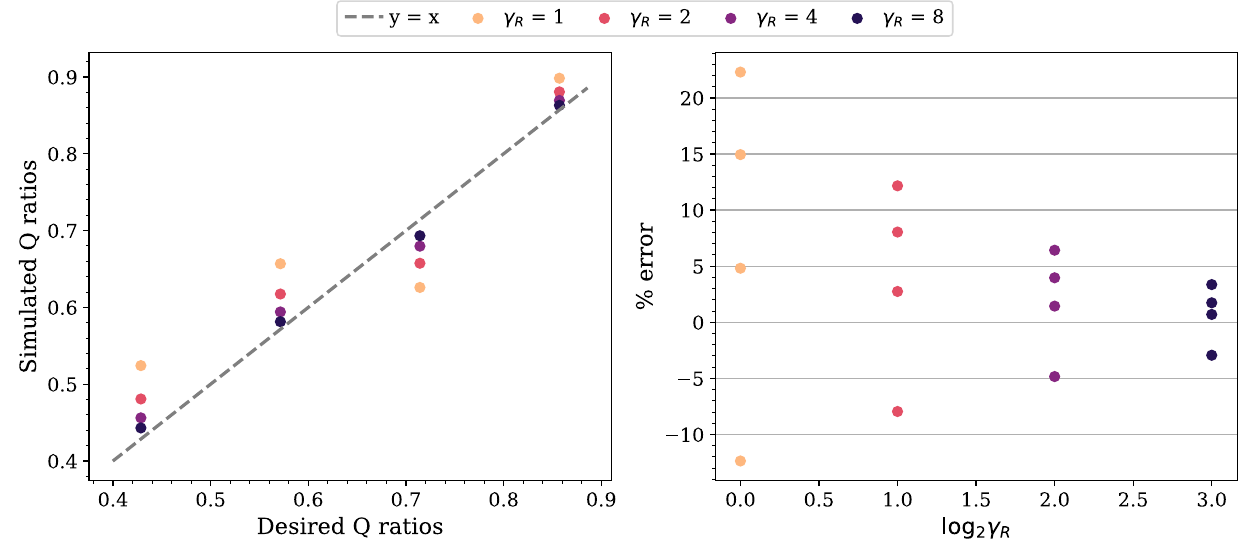
Figure 4. Comparison between the simulated and the desired flow rate ( Q ) ratios as γ R varies for a fixed γ RC /γ R . The results are obtained from the simulations on the fine grid of the five-outlets domain using γ RC /γ R 1 . With the outlet 4 arbitrarily chosen as a reference, the Q ratios of the other four outlets are obtained = for each γ R . We observe that the percentage error of the Q ratios decreases exponentially as γ R increases.